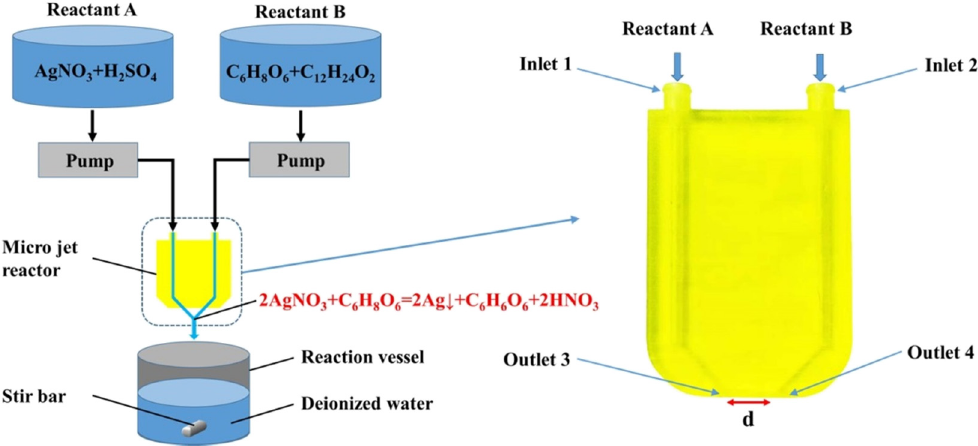
Figure 1: Schematic diagram of the micro - jet